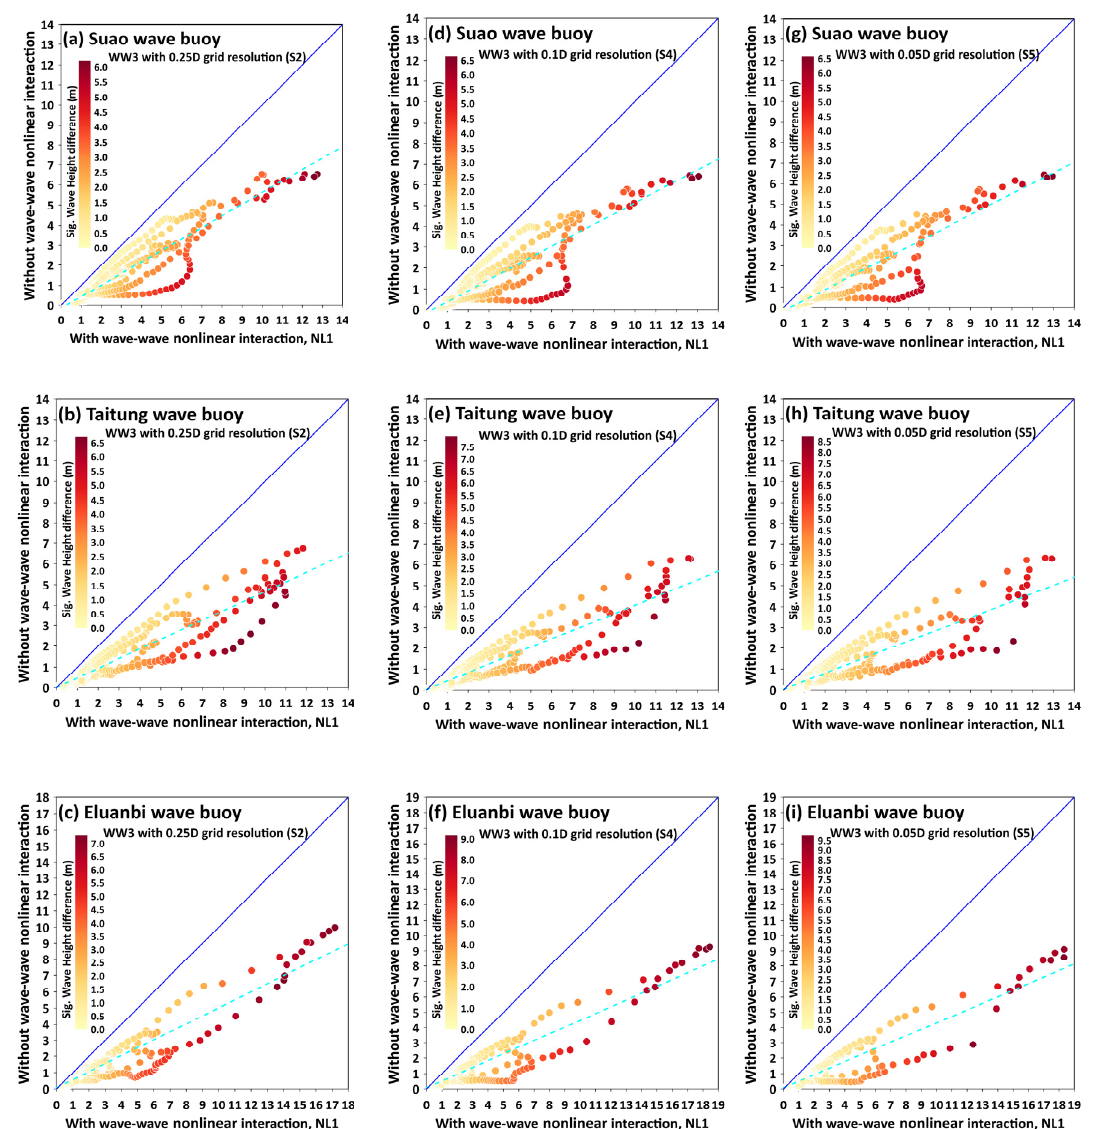
Figure 12. Comparison of the hourly significant wave height simulation when excluding and including the wave–wave nonlinear interaction using the WW3 model with 0.25 deg ( a – c ), 0.10 deg ( d – f ), and 0.05 deg ( g – i ) grid resolutions for ( a , d , g ) the Suao, ( b , e , f ) Taitung, and ( c , f , i ) Eluanbi wave buoys. The cyan lines represent the best linear regression between the wave height simulation with and without wave–wave interaction.